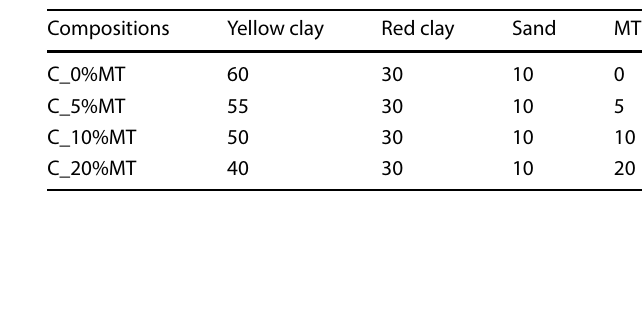
Fig. 6 Mine tailings and clays finer particle size distribution (lower than 63 microns)